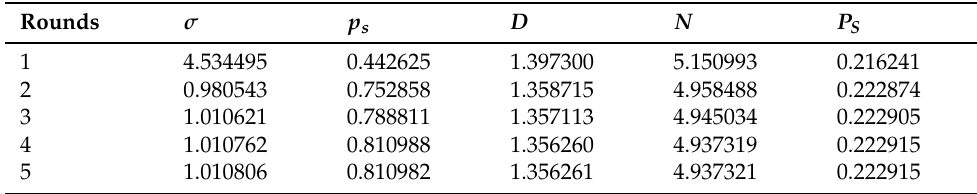
Table 2. Analytic Results by